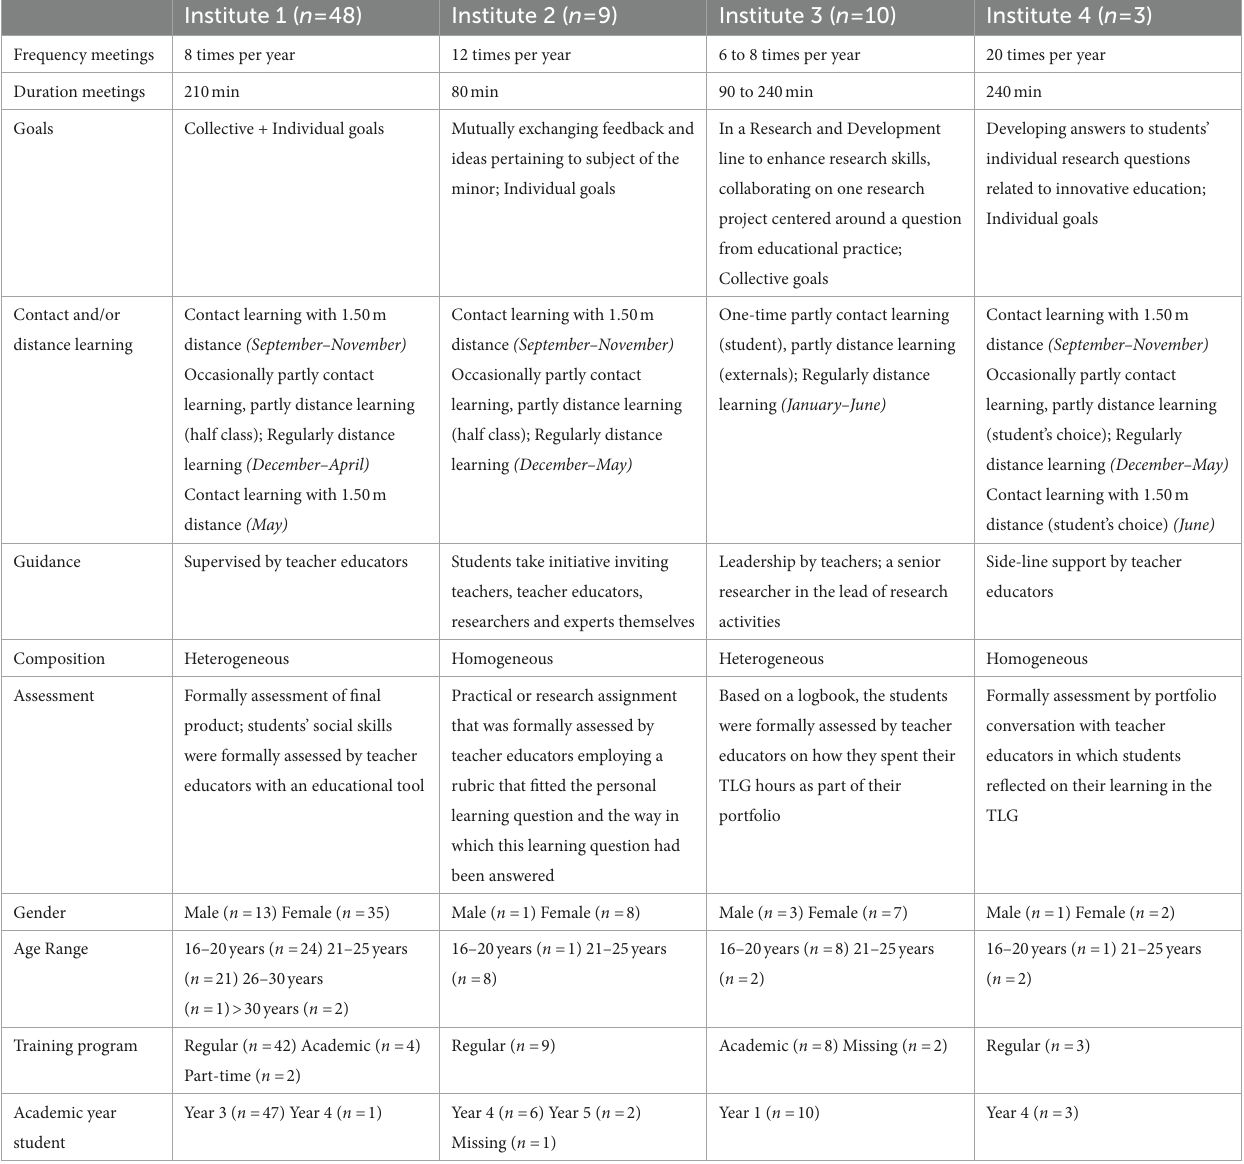
TABLE 1 TLGs’ organization of participating